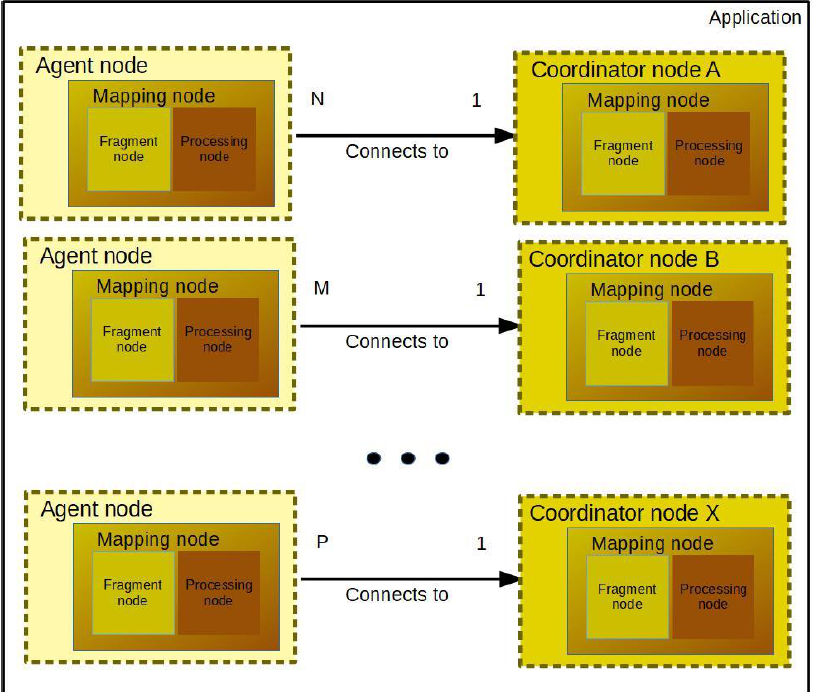
Figure 7. The structure of the topology template segment in a coordinator-driven, type-level TOSCA blueprint. Multiple agent nodes may be connected to one coordinator node and there can be an arbitrary number of coordinator